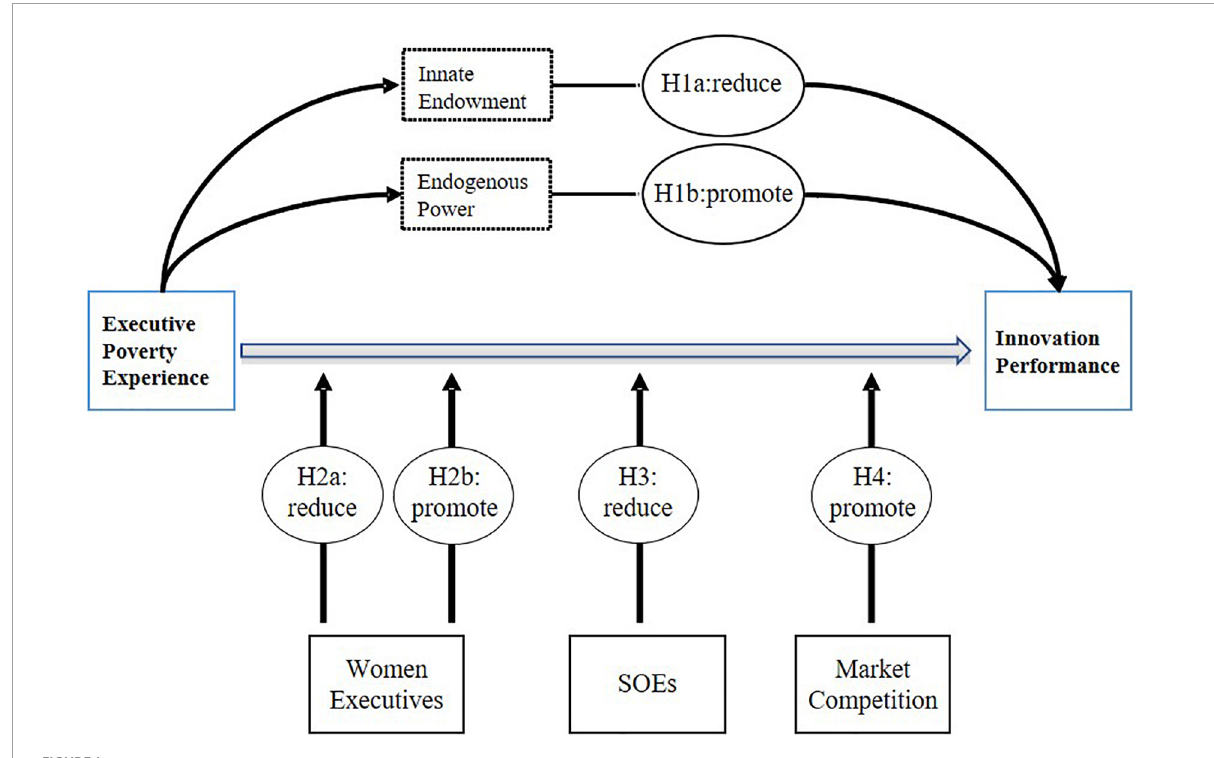
FIGURE1 Conceptual